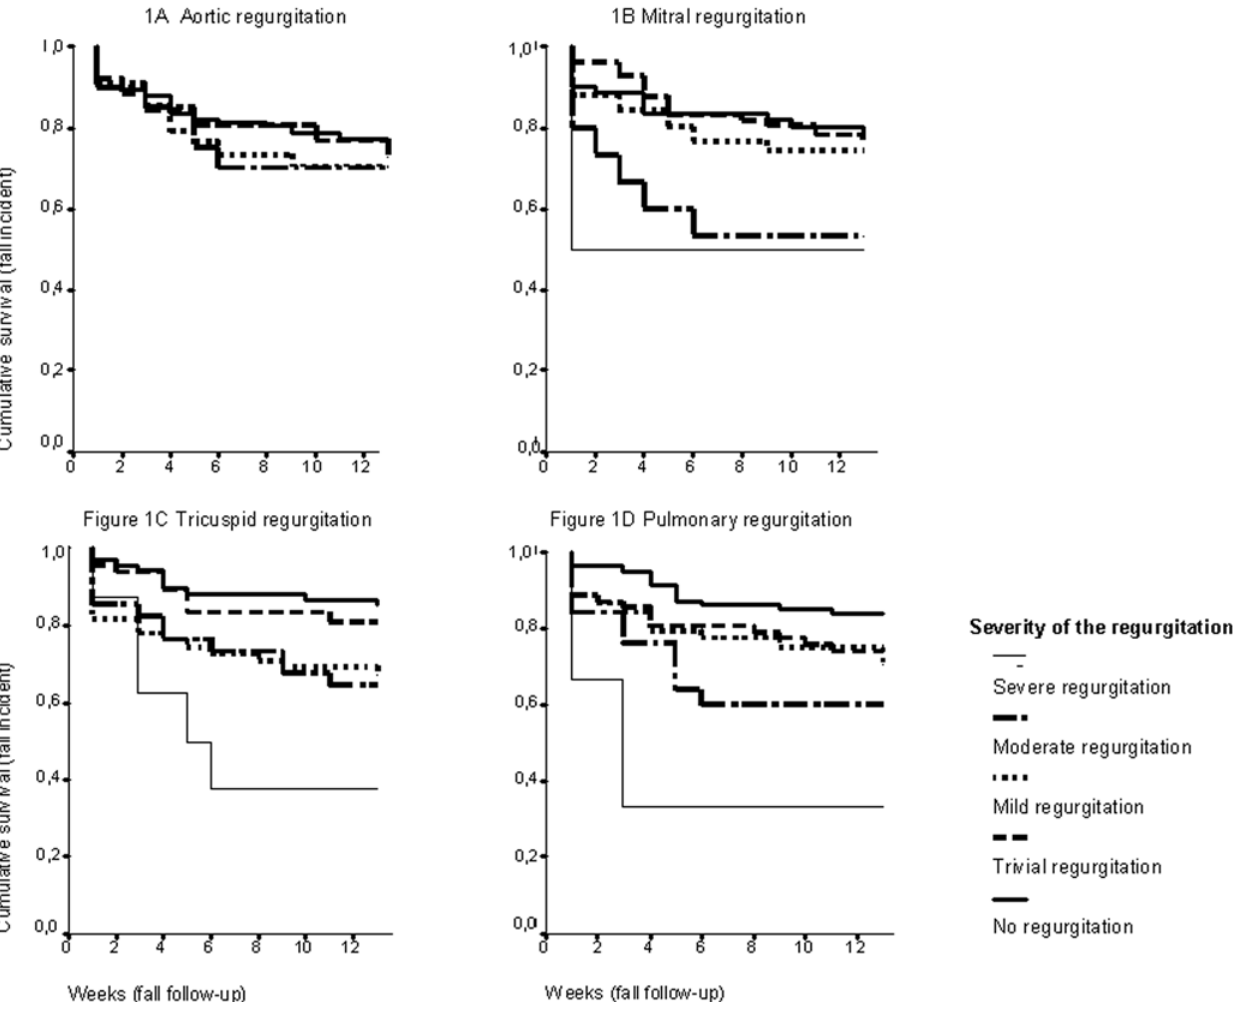
Figure 1. Kaplan-Meier Curve of Valve Regurgitation (Aortic, Mitral, Tricuspid and Pulmonary) According to Falls Incidence, Divided for Severity of the